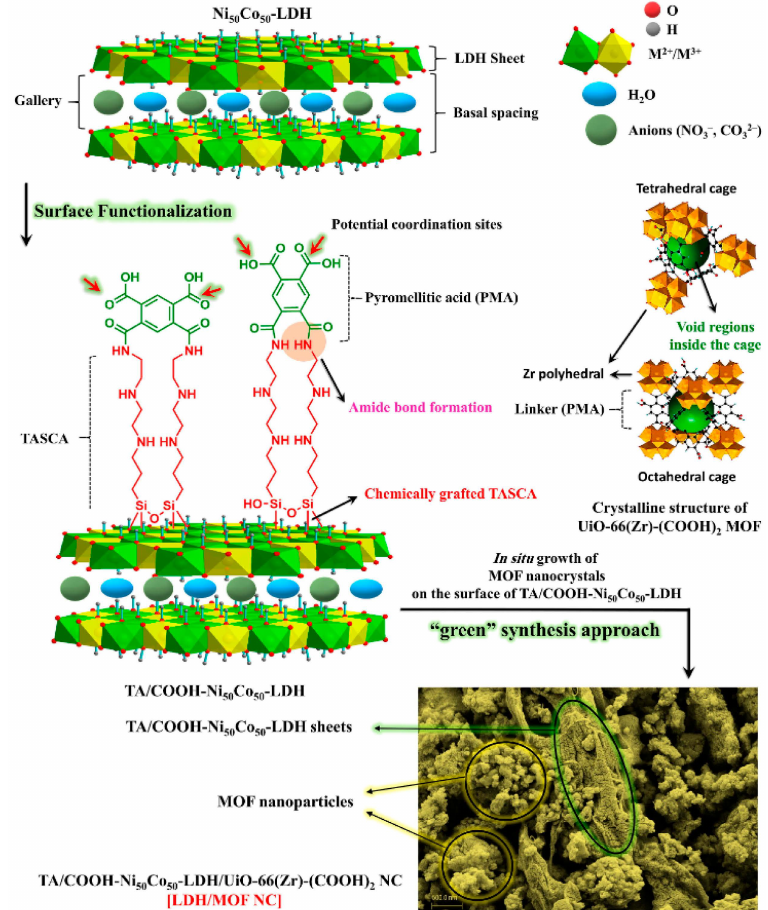
Figure 11. The overall synthesis process of the LDH/MOF NC. Reprinted with permission from Ref. [113]. Copyright 2021,